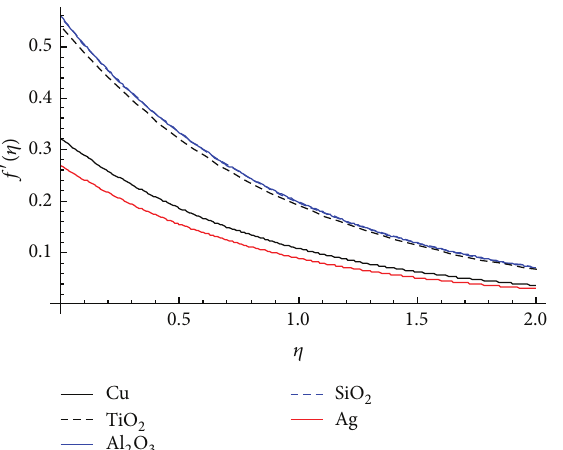
Figure 15: Comparing the variation of velocity distribution 𝑓 󸀠 (𝜂) for the investigated nanoparticles when 𝑃𝑟 = 6.2 , 𝛿 1 = 1 , 𝛿 2 = −1 , 𝑠 = 0.5 , and 𝜙 = 0.1 .